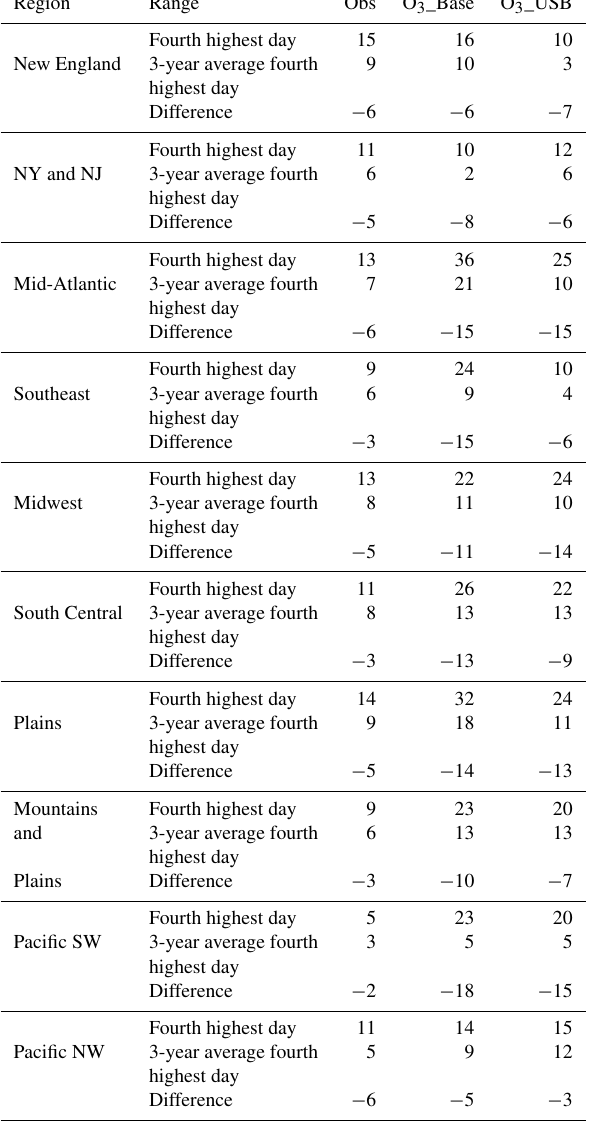
Table 5. Summary information for each region. The first row next to each region reports the range across 2004–2012 of the fourth highest MDA8 O 3 values from each of the 9 individual years for the observations, O 3 _Base, and O 3 _USB. The second row reports the range across 2004–2012 of each of the 3-year averages of the fourth highest values (7 values) in each region for the observations, O 3 _Base, and O 3